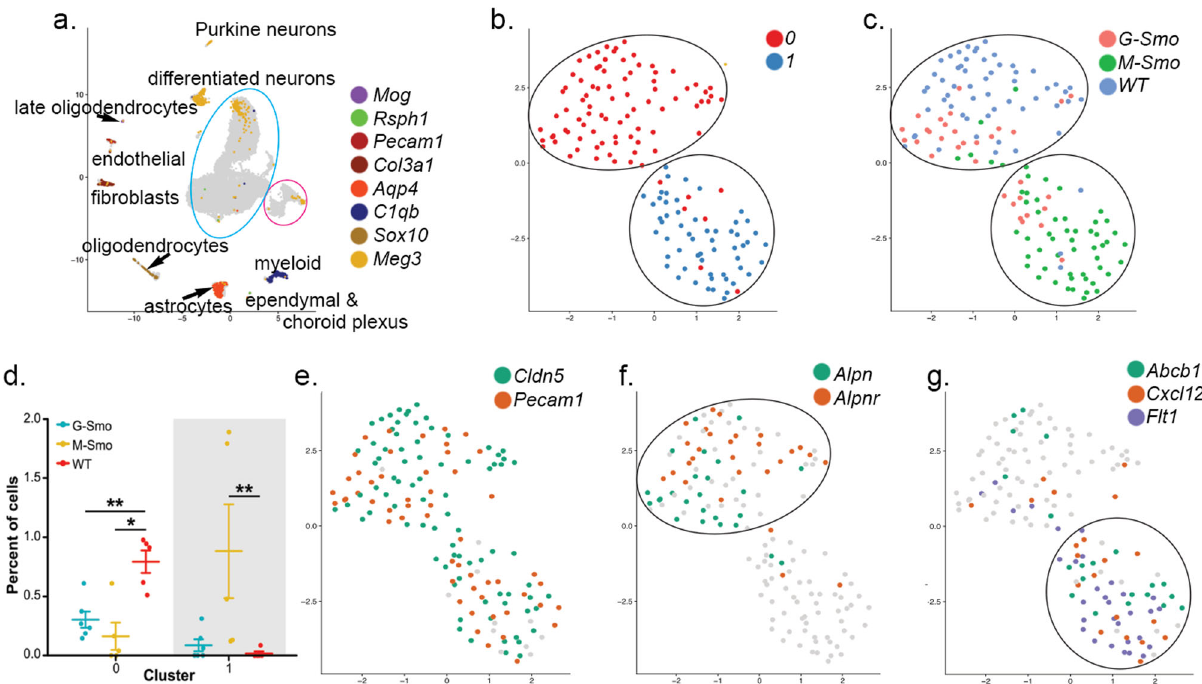
Fig. 5 Tumor-speci fi c gene expression in endothelial cells. a UMAP plot of cells from G-Smo and M-Smo tumors combined with cells from P7 WT cerebella, analyzed using the Harmony algorithm. The blue circle shows the region where neural progenitor-like tumor cells and CGNPs localize. The pink circle shows the GABAergic interneuron lineage. Stromal cell types are identi fi ed by the expression of the indicated, color-coded markers. b UMAP showing endothelial cells from G-Smo , M-Smo , and P7 WT, with clusters color-coded. c genotype color-coded on the UMAP from b . Circles indicate the positions of the clusters. d Comparison of the indicated cluster populations in G-Smo , M-Smo, and P7 WT. Student ’ s test was used in d . Dots represent values for individual replicates, bars indicate the means and whiskers indicate the SEM. e – g Feature plots on UMAP from b , showing expression of e endothelial markers Cldn5 and Pecam1 , f Cluster E 0 markers Apln and Aplnr , or g tumor-speci fi c Cluster E 1 markers Abcb1a (aka Mdr1 ), Cxcl12, and Flt1